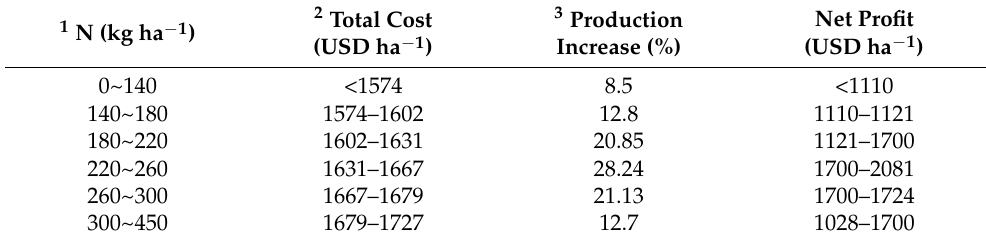
Figure 9. Relative change rates for different N fertilizer application amounts. Description of symbols: AN, soil alkaline-hydrolysable nitrogen; TN, soil total nitrogen; SOC, soil organic matter; C:N, the soil carbon to nitrogen ratio; and TNA, total N accumulation. Numbers in parentheses represent the effect value (lnR). Table 1. Output value, total cost, and net income of rice under different N fertilizer application rates.